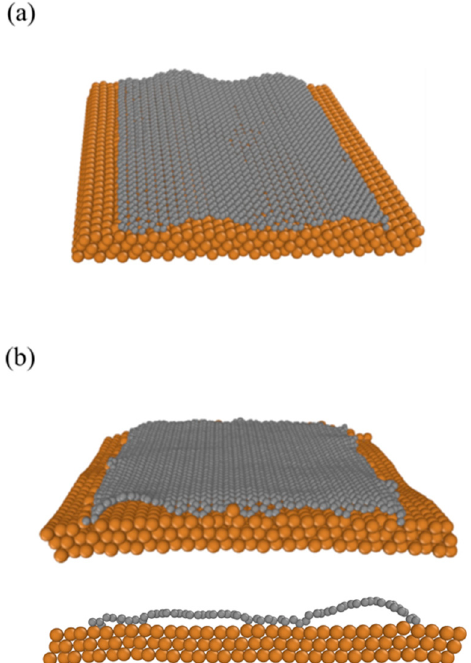
Figure 3. Graphene sheet on Cu surface (see Supplementary Materials). ( a ) Rippled graphene sheet on Cu surface before simulated annealing. ( b ) Rippled graphene sheet on Cu surface after simulated annealing at 77 K. Orange/grey spheres indicate Cu/C atoms, respectively.